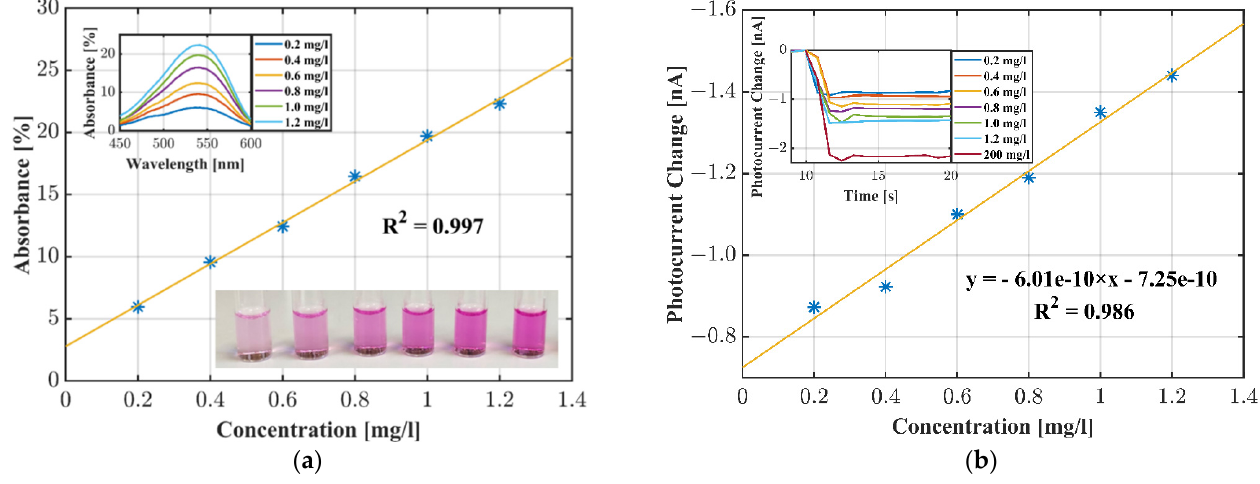
Figure 7. ( a ) UV-Vis reference measurement evaluated at 540 nm; ( b ) nitrite measurement and the calibration plot for the nitrite standard solutions obtained with the OLED–OPD unit and the azo dye absorbance.